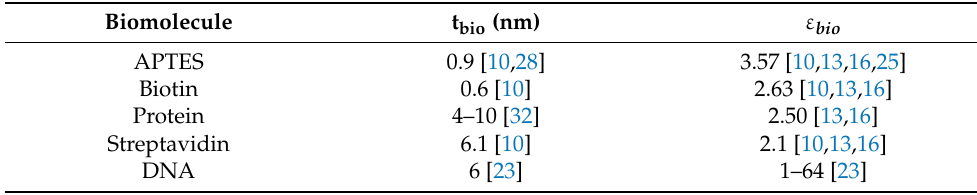
Figure 3. Comparison of the simulated result with the experimental results [30] for n-type JL-DM- GSDG-MOSFET at V ds = 50 mV. Table 2. List of biomolecules with their permittivity